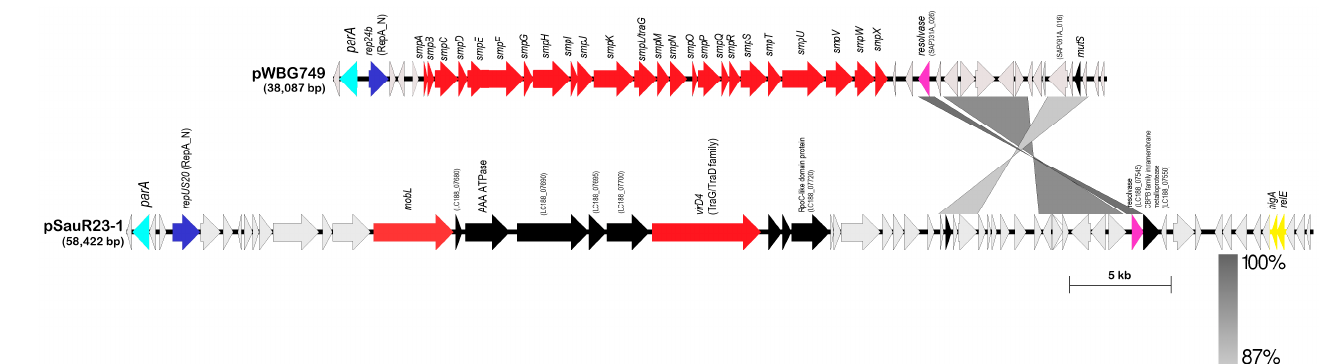
Figure 5. Linear genetic maps of conjugative plasmid pSauR23-1 in comparison with its closest characterized relative, the conjugative plasmid pWBG749 (accession no. GQ900391; [72]). Arrows indicate the size and orientation of known genes and putative ORFs with unknown functions. Regions with greater than 87% nucleotide sequence identity are depicted as shaded grey areas with darker shades of grey indicating higher nucleotide sequence identities (87–100%). Although both plasmids encode replicases with the RepA_N conserved domain (showed as dark blue arrows), the replicases only shared 34% amino acid sequence identity and were typed by PlasmidFinder as repUS20 for pSauR23-1 and rep24b for pWBG749. In both plasmids, a pSK1 par -like gene that encodes a single par protein (DUF536) could be found divergently transcribed from their respective rep genes (shown as sky-blue arrows and labeled parA ). The smpA–smpX conjugative gene cluster in pWBG749 [26] is indicated in red arrows. Note that no signi fi cant sequence identity was observed between the pWBG749 smp gene cluster and the putative conjugative gene cluster in pSauR23-1. Two ORFs in pSauR23-1, mobL and virD4 (red arrows), give rise to proteins predicted to be the conjugative relaxase and T4SS coupling protein. Other ORFs are indicated in black arrows with conserved motifs (if any) labeled. Predicted resolvase/serine recombinase genes are shown in pink. The type II toxin-antitoxin system identi fi ed in pSauR23-1, higA-relE , is colored yellow. Light grey arrows depict hypothetical ORFs.